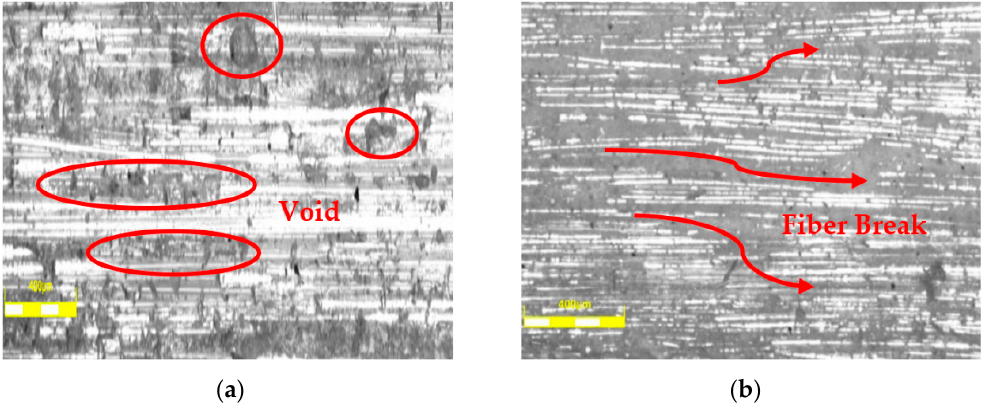
Figure 7. Microscopic images of group A: ( a ) N = 5567; ( b ) N = 9450.